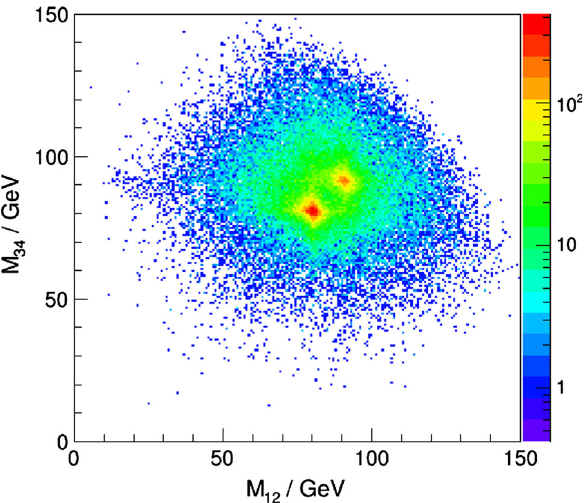
Fig. 8 The GenJet level distribution of M 12 versus M 34